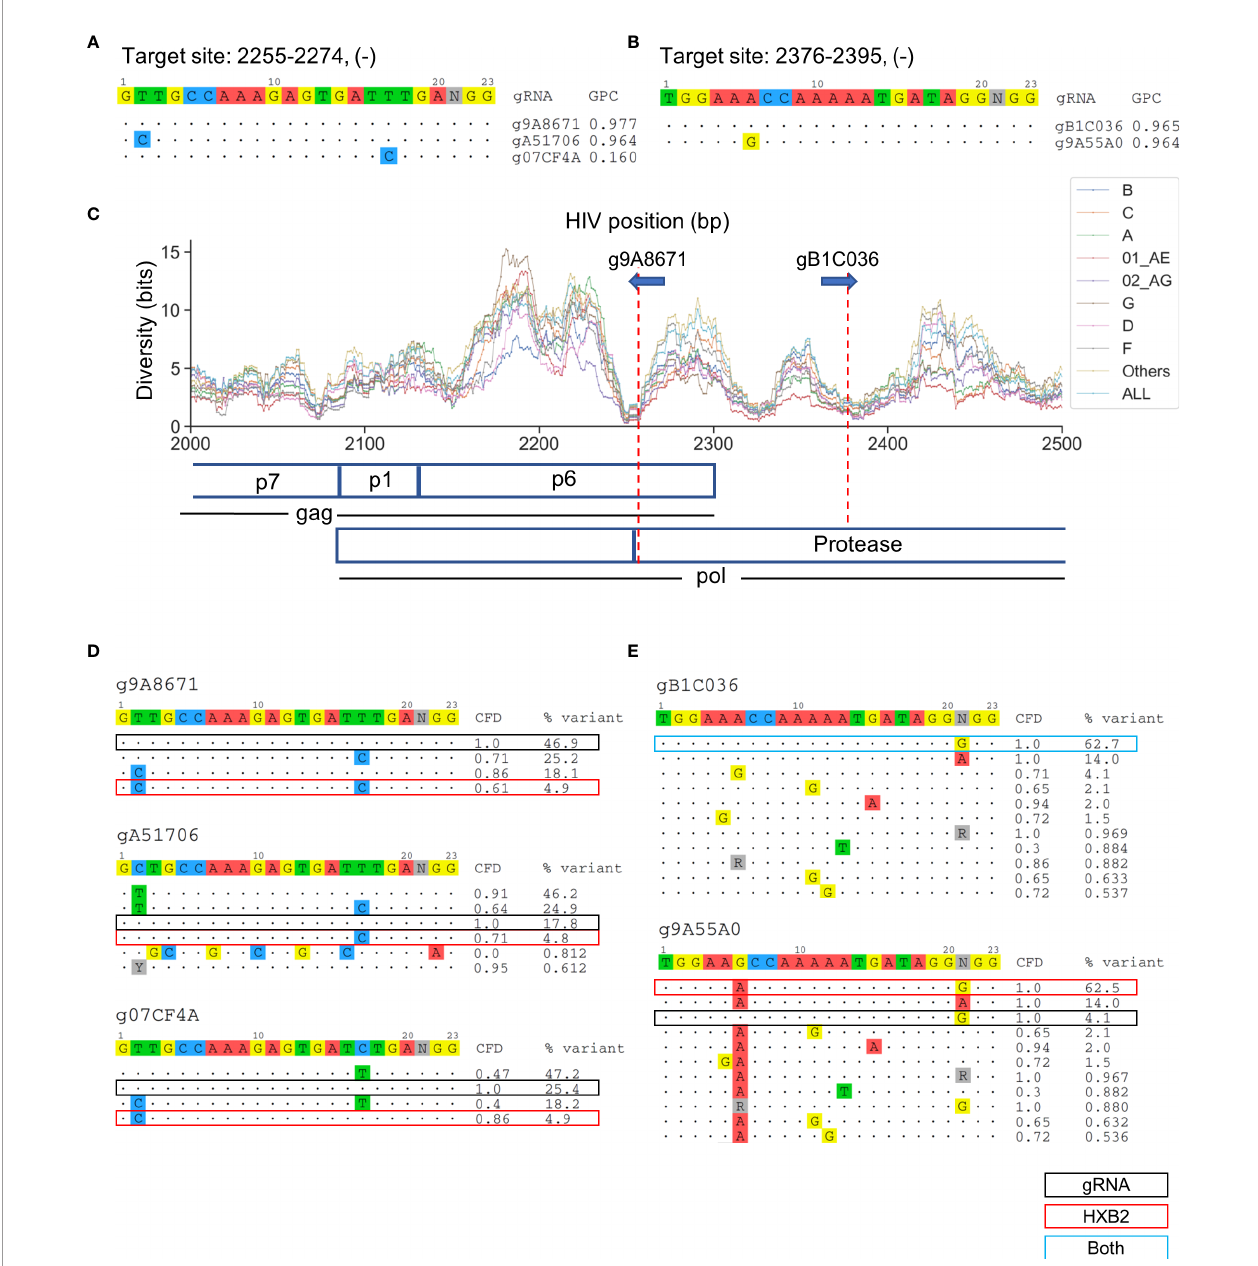
FIGURE 4 | The selection of absolute sequence is likely to affect consequent CRISPR-mediated editing ef fi cacy across sequence variants. (A) All candidate gRNAs targeting position 2255 – 2274 (-) among 1,330 candidate gRNAs. (B) All candidate gRNAs targeting position 2376 – 2395 (-) among 1,330 candidate gRNAs. (C) The subtype-speci fi c sequence diversity across the HIV-1 genome between position 2000 and 2500. Both g9A8671 and gB1C036 were predicted to cleave the protease protein in a locally low diversity region. gRNA589 was also predicted to cleave p6. (D, E) Sequence variant pro fi les and corresponding CFD score between chosen gRNA and HIV-1 variants. “ HXB2 ” label next to the % variant represents the variant frequency of the sequence that possessed identical sequence against